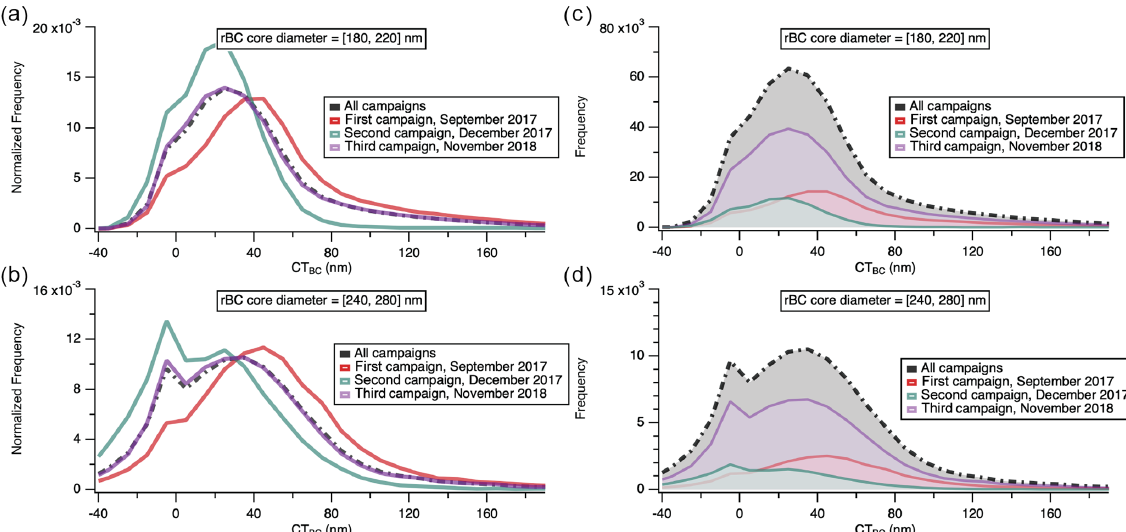
Figure 8. Distributions of BC coating thickness (CT BC ) aggregated by campaign are shown in red (first campaign), green (second campaign), and purple (third campaign). The combined distributions for all campaigns are shown in black. Panels (a) and (b) show the normalized frequency distributions, and panels (c) and (d) show the absolute frequency distributions. The distributions are also distinguished by the rBC core diameter ranges included in the LEO analysis. Panels (a) and (c) show distributions for particles with rBC core diameters between 180 and 220nm; panels (b) and (d) show distributions for particles with rBC core diameters between 240 and 280nm.